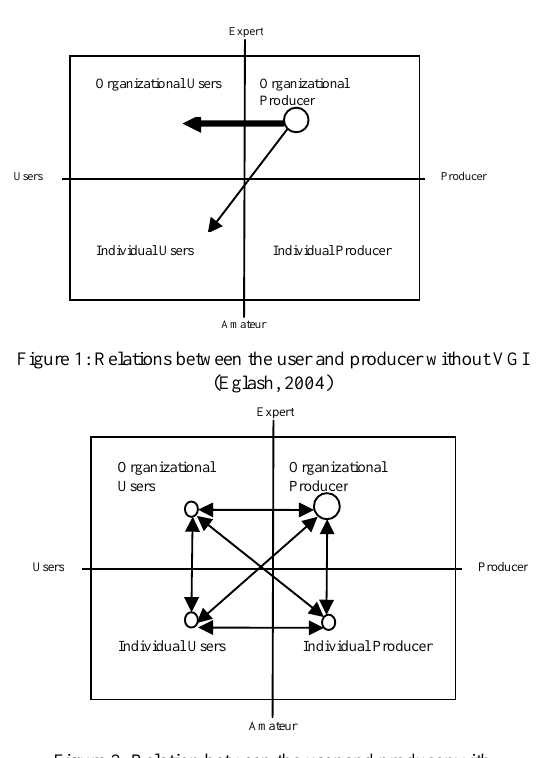
Figure 2: Relation between the user and producer with VGI(Budhathoki, 2010) As Budhathoki (Budhathoki, 2010) believes that